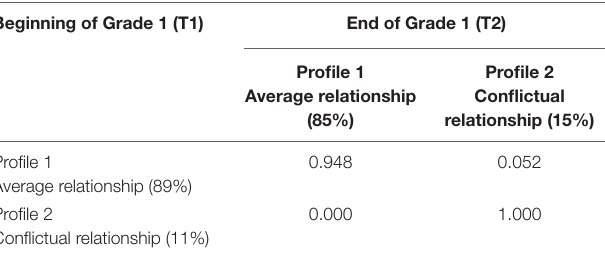
TABLE 5 | Latent transition probabilities between the beginning (T1) and end (T2) of Grade 1. Beginning of Grade 1 (T1)